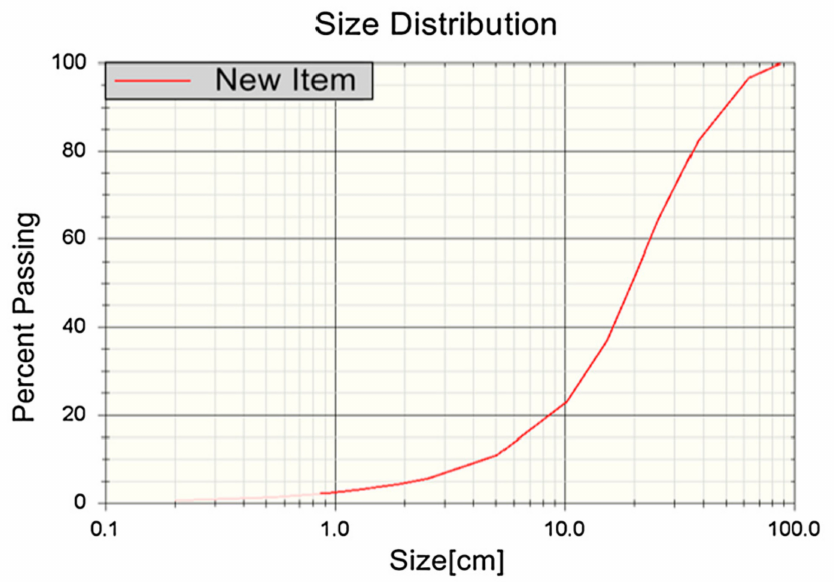
Figure 9. Sample of Split-Desktop curve used for size distribution analysis